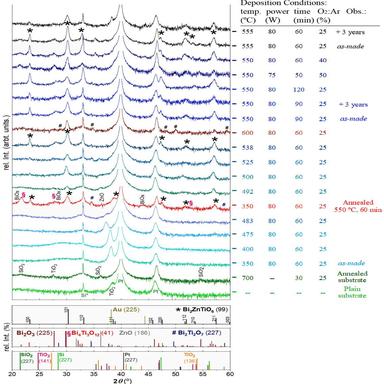
XRD patterns of the Si(001)/SiO2/TiO2/Pt(111) plain standard substrates used, before and after thermal passivation. Comparison of XRD patterns of the series of thin films deposited at different substrate temperatures; rf-power; time; O2:Ar ratio and thermal treatments. (bottom): Reference spectra of indexed phases for: substrates spurious compounds; BZT and Au electrodes.